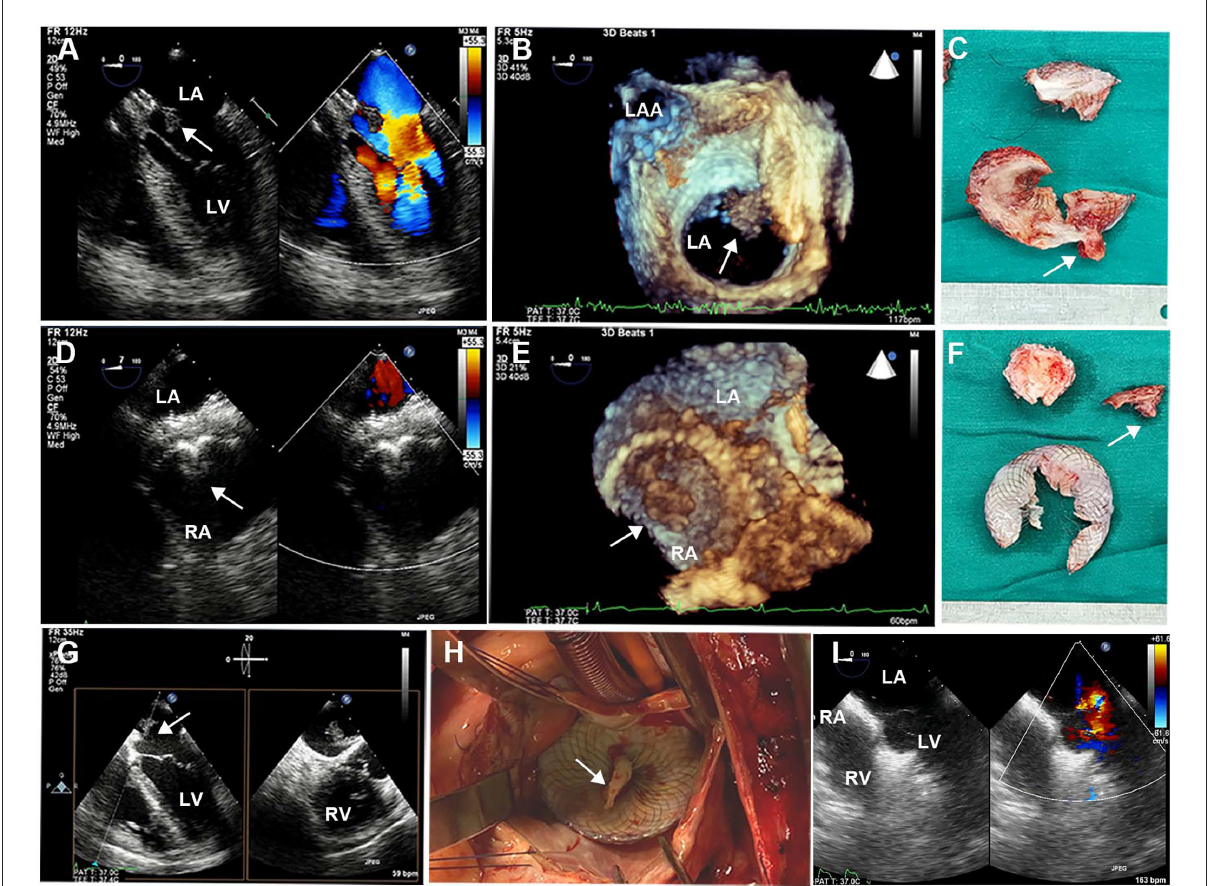
FIGURE2 Intraoperative TEE and surgical images. (A,D) 2D-TEE color Doppler showed an ASD device with a double-sided thrombus. (B,E) 3D-TEE demonstrated a fan-like left-atrial thrombus attached to the device and a short rod-like right-atrial thrombus attached to the device. (C,F) Surgical resection of ASD device fragments with bilateral thrombus. (G) Biplanar TEE showed a giant thrombus floating in the left atrium. (H) Left atriotomy showed a white thrombus attached to the device. (I) Postoperative TEE showed continuous atrial septum without shunt and thrombus. TEE, transesophageal echocardiography; ASD, atrial septal defect. White arrows represent